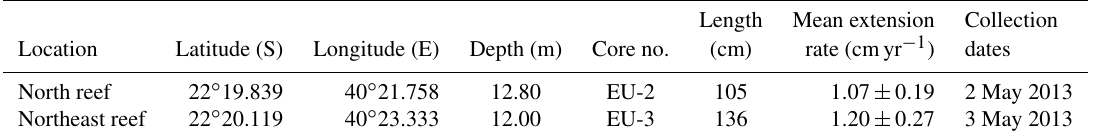
Table 1. Coral core GPS locations from Europa, water depth, core name, core length, mean extension rate between 1968 and 2012 ( ± standard deviation in brackets), and collection